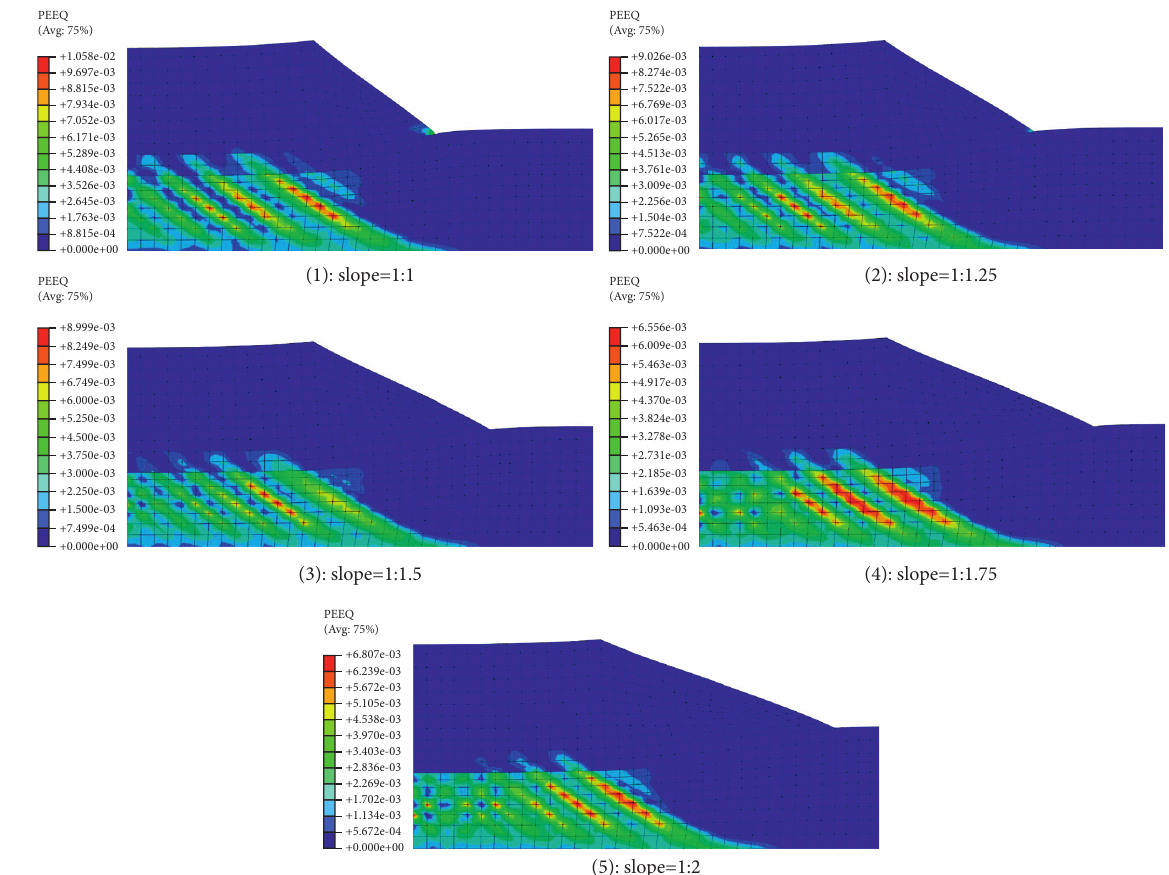
Figure 4: Effects of road slopes on PEEQ. (a) Slope � 1:1. (b) Slope � 1:1.25. (c) Slope � 1 :1.5. (d) Slope � 1:1.75. (e) Slope �